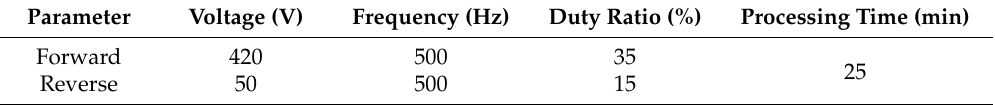
Table 1. The parameters setting of plasma electrolytic oxidation power supply.